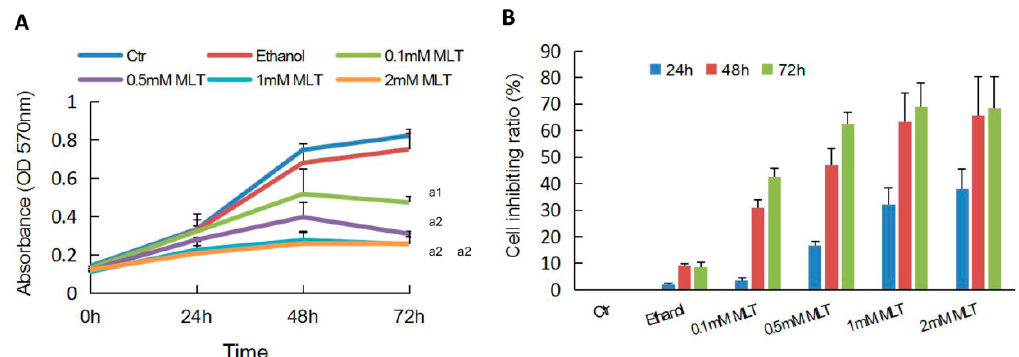
Figure 1. Melatonin inhibited the proliferation of human colorectal carcinoma cell line HCT 116 cells. ( A ) HCT 116 cells were treated for 0, 24, 48 or 72 h with various concentrations of melatonin (0.1, 0.5, 1, and 2 mM) or vehicle (0.1% ethanol). Absorbance at OD 570 nm was measured by MTT assay; ( B ) the inhibition ratio of HCT 116 cells exposed to various concentrations of melatonin after 24, 48 or 72 h of treatment was detected. The cell inhibition ratio = (1 − OD value treated group /OD value control group ) × 100%. Data are presented as the mean ± SD. a1 p < 0.05; a2 p < 0.01 vs. control.